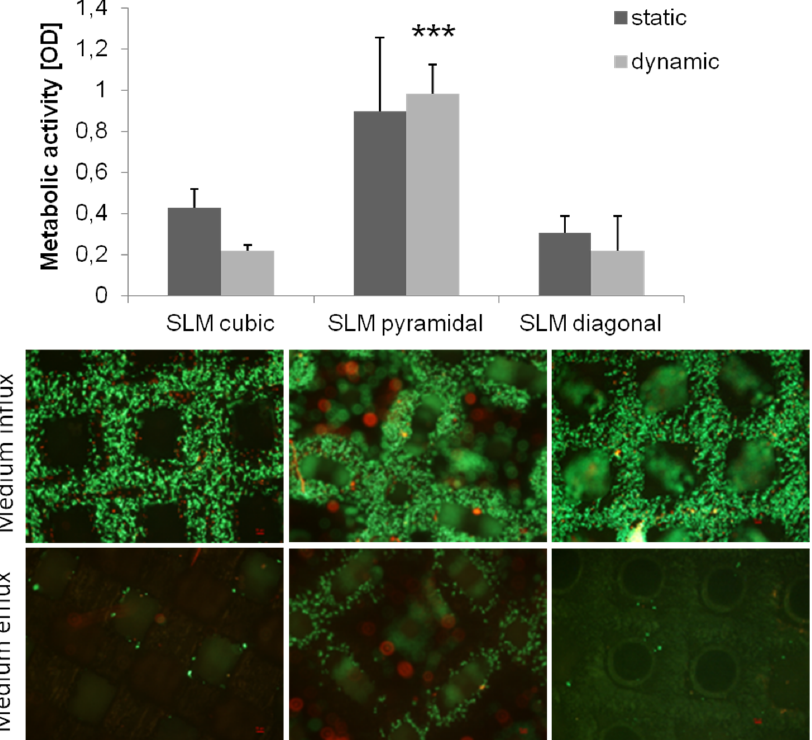
Figure 12. Metabolic activity of human osteoblasts cultured on SLM manufactured scaffold with several designs under dynamic and static conditions after four days of cultivation. Values are means ± SD ( n ≥ 3). ANOVA Post-Hoc-LSD: Statistical significance levels ( *** p < 0.001) compared to the further designs after dynamic cultivation. Statistic revealed no significant differences between static and dynamic cultivation (above). Live/dead staining of SLM manufactured scaffolds after dynamic cultivation after four days. Living cells are displayed in green, dead ones in red. Magnification: 40×. Scale bar: 50 µm (down right) (below).